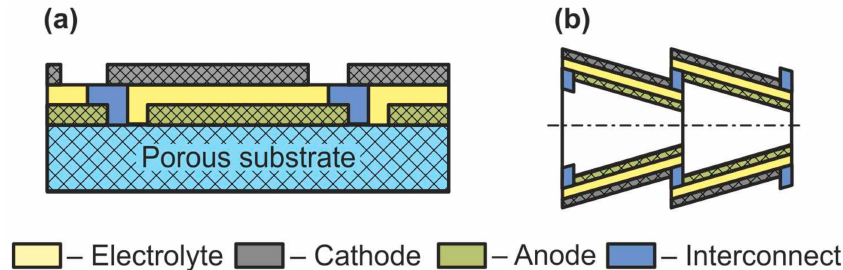
Figure 9. Schematics of ( a ) segmented-in-series SOFC and ( b ) cone-shaped